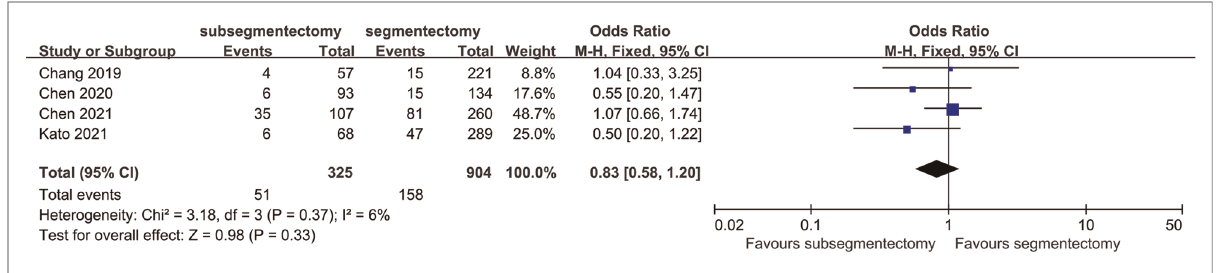
FIGURE 7 Forest plot: the postoperative complications of subsegmentectomy vs. segmentectomy.